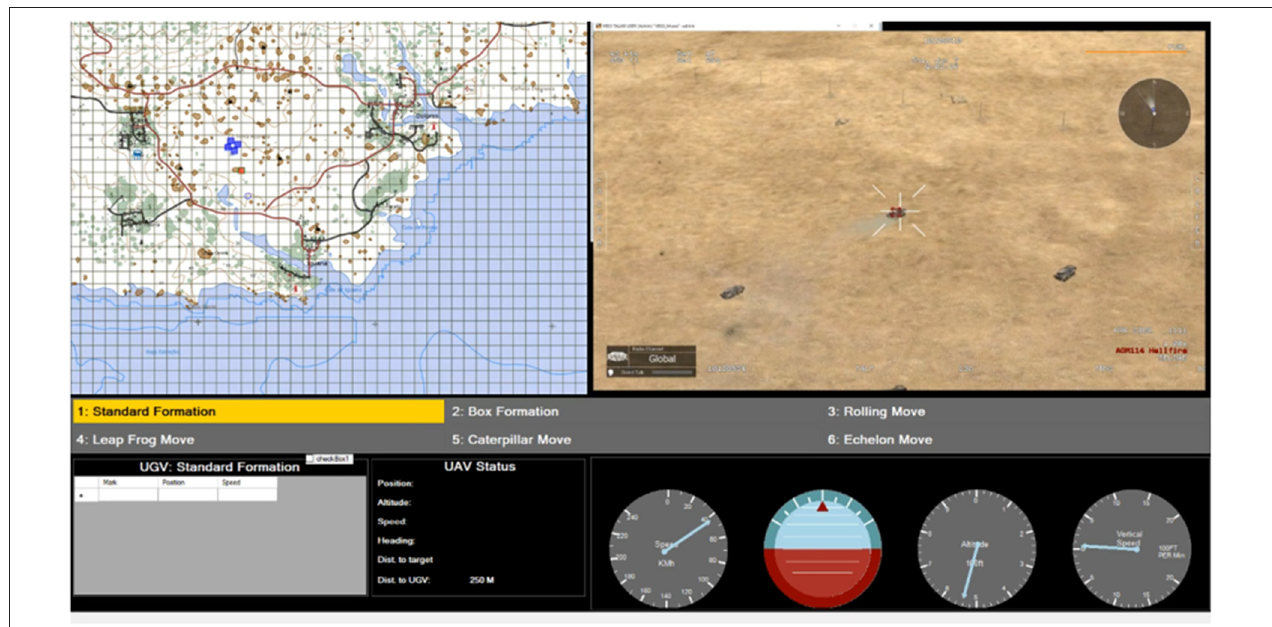
FIGURE 1 | UAV pilot interface.